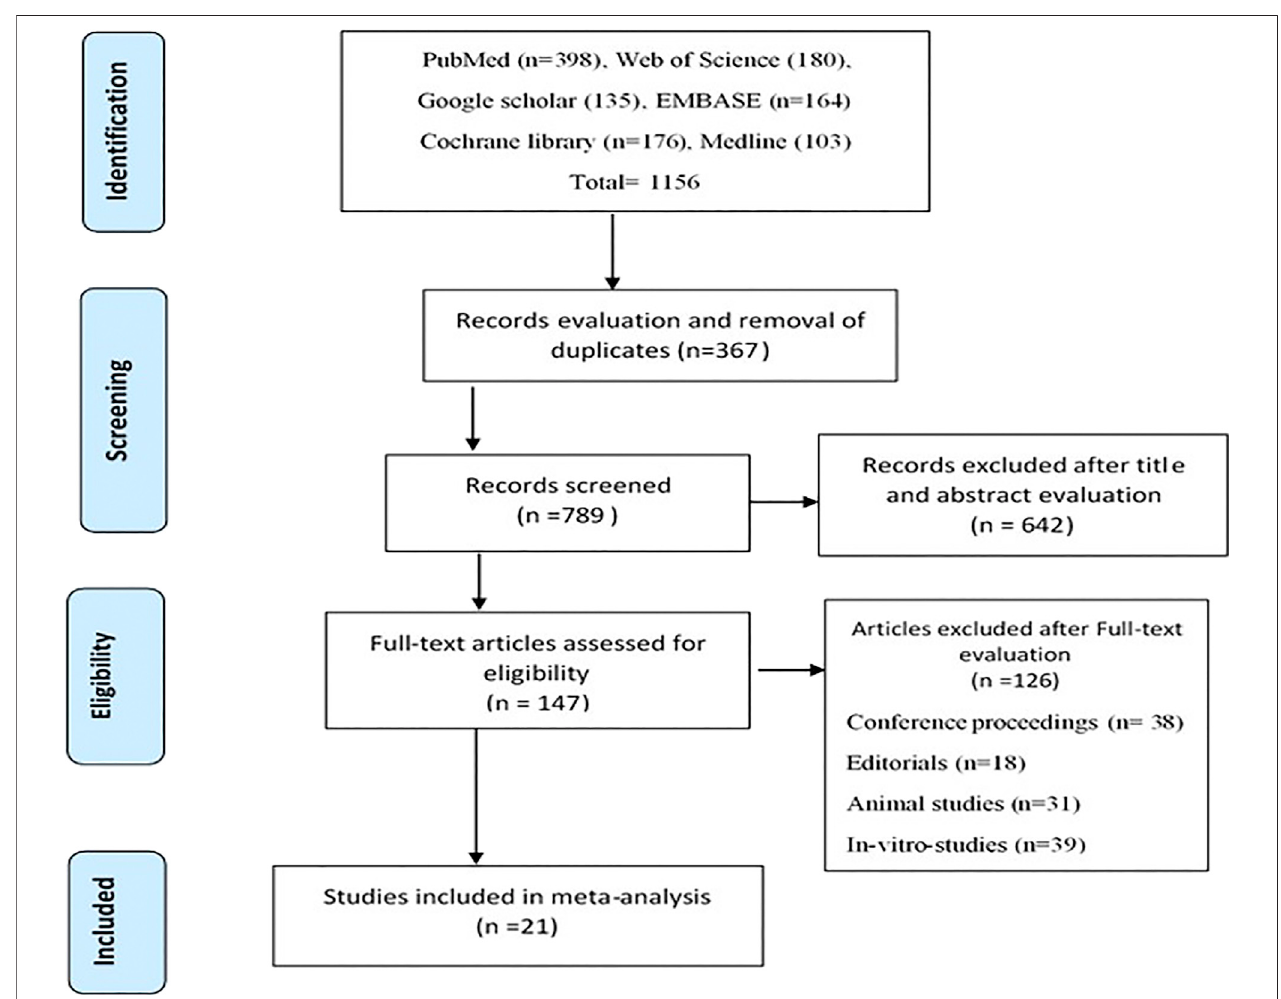
FIGURE 1 | Prisma fl ow chart of study